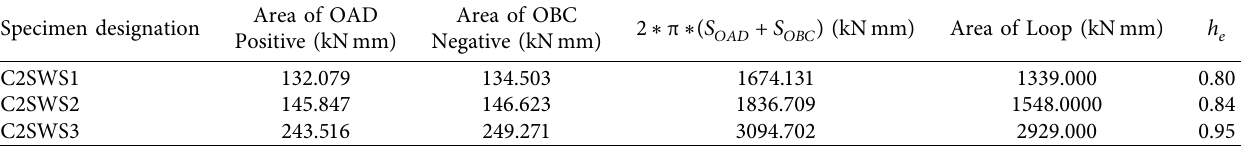
Table 6: Cumulative energy dissipation and viscous damping ratio of 90 ° -type connection.